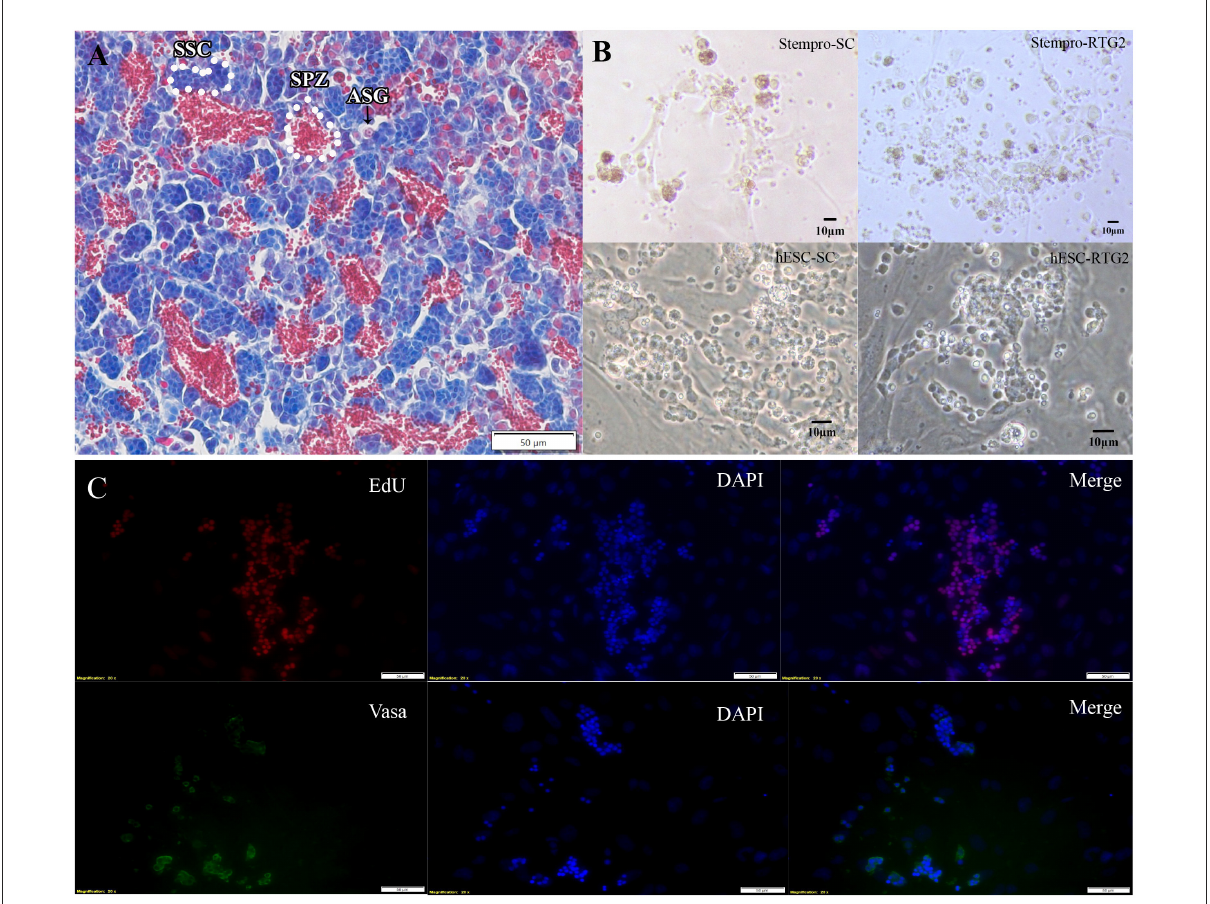
FIGURE3 (A) Histological observation of common carp gonads. Various germ cell populations are indicated by arrowhead or white broken lines. (B) Morphology of cells cultured under different condition. (C) Immunocytochemistry of cultured cells at day 14. hESC-SC, hESC medium